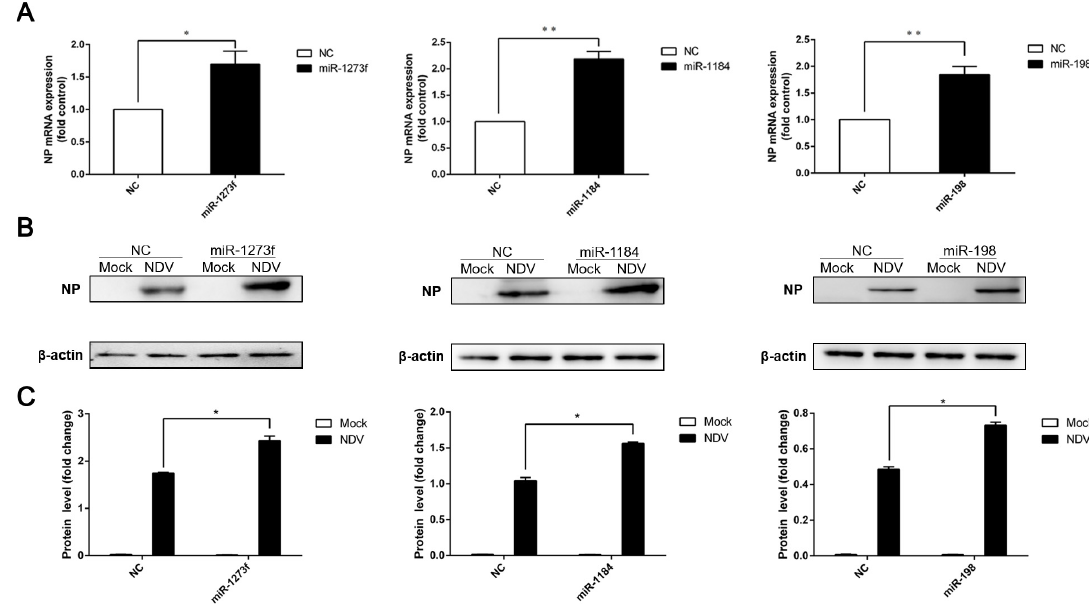
Figure 6. MicroRNAs benefit NDV replication. ( A ) Nucleocapsid protein (NP) mRNA was detected with RT-qPCR in HeLa cells transfected with miRNA mimics and then infected with NDV. β -Actin was an internal control. ( B ) NP protein was detected by Western blot in HeLa cells transfected with miRNA mimics and then infected with NDV. β -actin was an internal control. ( C ) The integrated density of NP expression was analyzed in ( B ) with Image J software 1.8.0. β -actin was an internal control. Error bars are the SEM from three independent experiments. Statistical significance is indicated: ** p < 0.01 and * p <